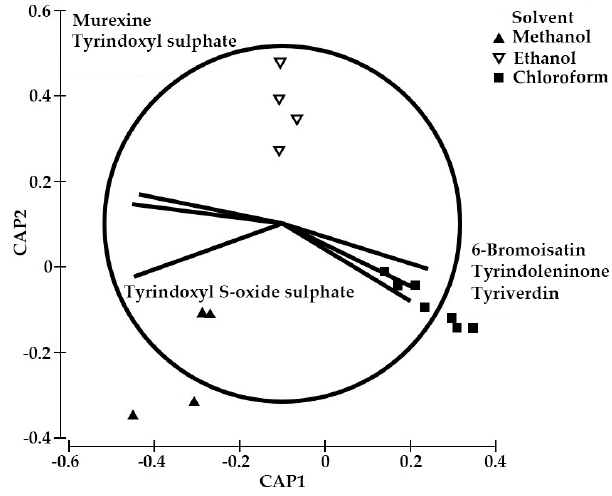
Figure 6. Canonical analysis on the principal coordinates (CAP) based on the secondary metabolites from the hypobranchial gland of Dicathais orbita detected in different organic solvents, with vector overlay based on Spearman correlation >